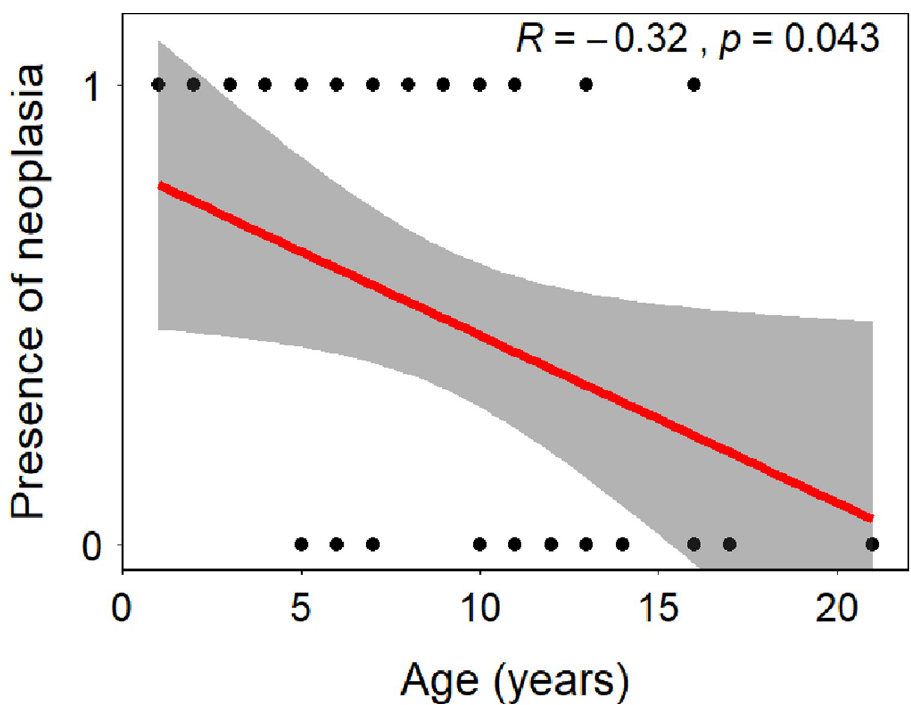
Fig 1. Correlation (+ CI) between the age of the individuals and the presence of neoplasia. Statistics indicate Spearman’s rho and the p-value associated with the correlation.